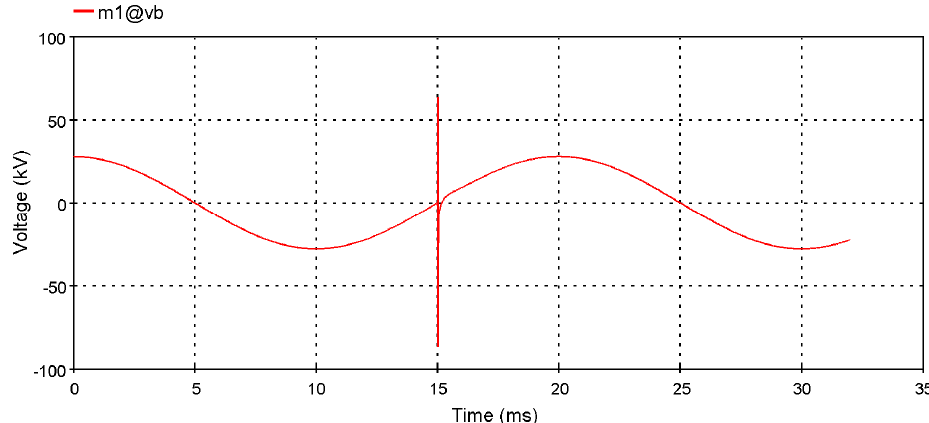
Figure 7. Overvoltage at the secondary side of the main power transformer.